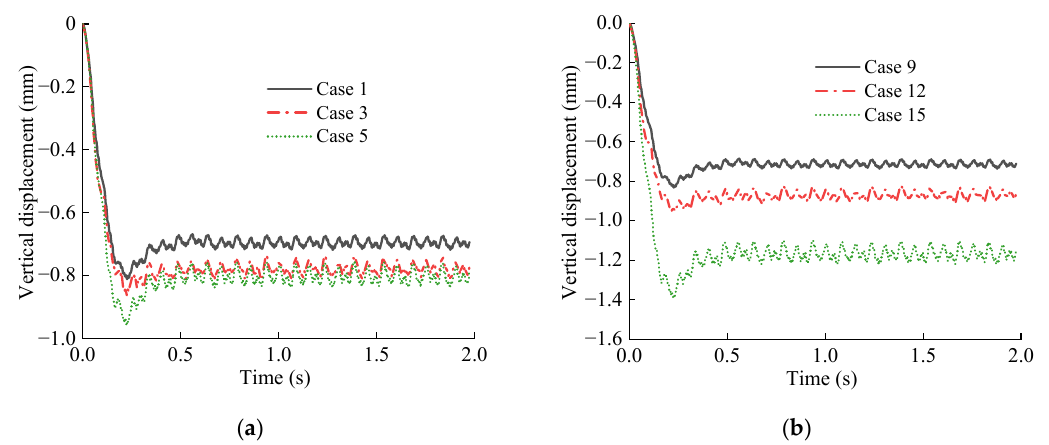
Figure 9. Vertical displacement time–history curve of measuring point B: ( a ) Different softening coefficients; ( b ) Different softening thickness.